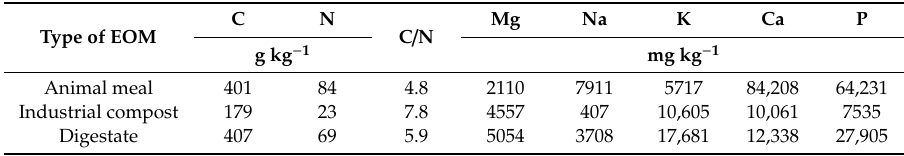
Table 2. Chemical composition of the applied